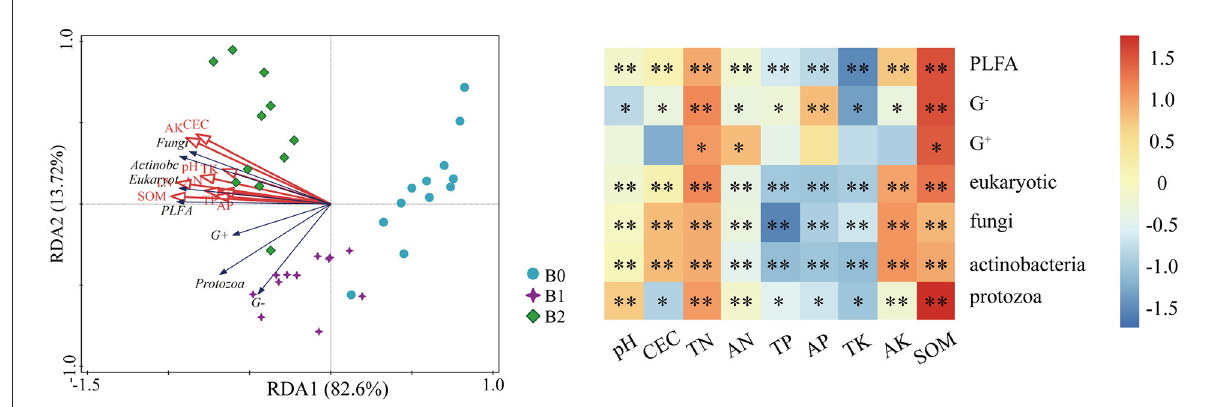
FIGURE7 The redundancy analysis (RDA) and heatmap based on different treatments and microbial community compositions and soil fertility properties. * and ** Significant difference at p = 0.05 and p = 0.01,